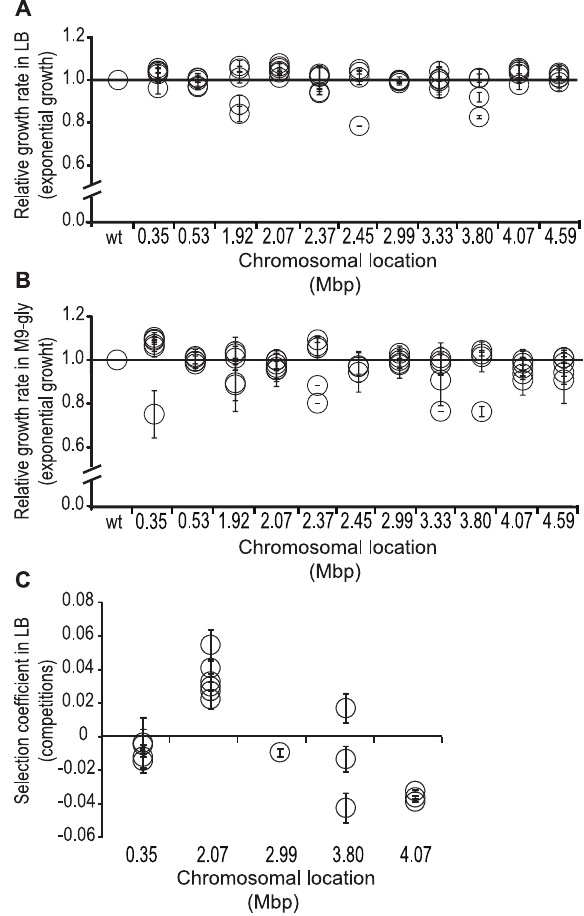
Figure 2. Relative fitness of mutants with deletion of different chromosomal regions. ( A ) Relative exponential growth rates (parental strain set to 1.0) in single cultures for mutants with deletion of different chromosomal regions during growth in rich LB medium. ( B ) Relative exponential growth rates (parental strain set to 1.0) in single cultures for mutants with deletion of different chromosomal regions during growth in minimal (M9) glycerol medium. ( C ) Selection coefficients of deletion mutants obtained from competition experi- ments in rich LB medium with an isogenic parental control (defined as